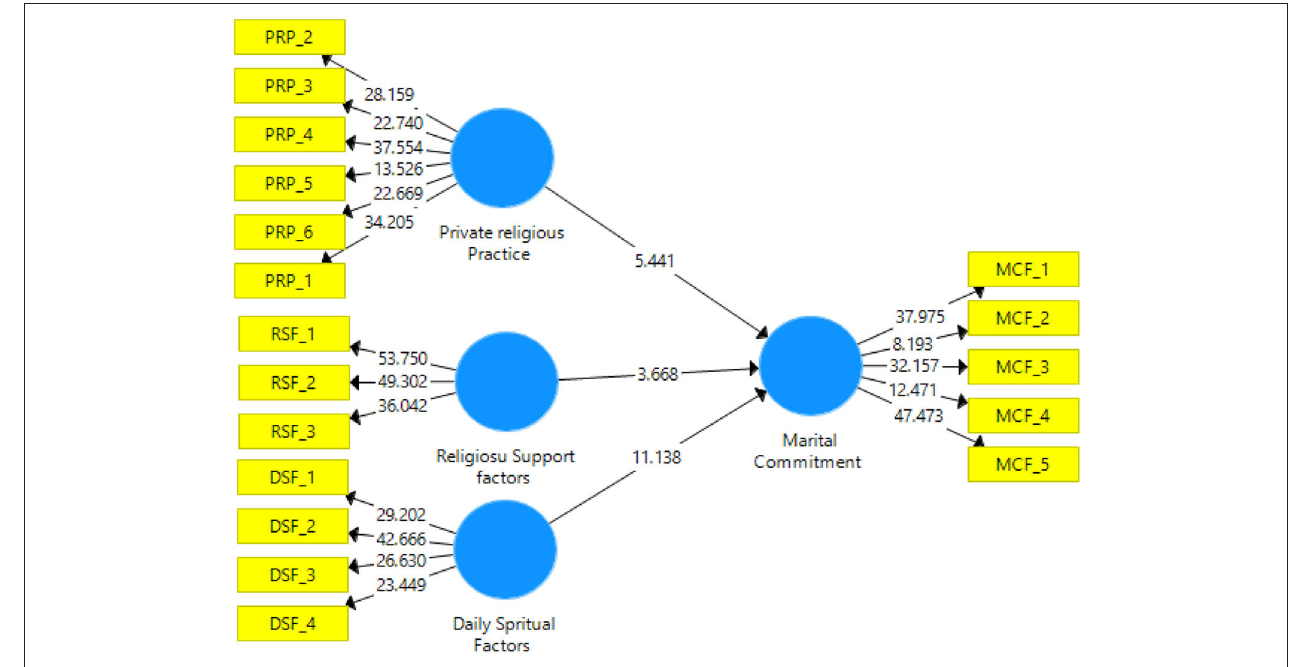
FIGURE 3 | The t -test statistics.